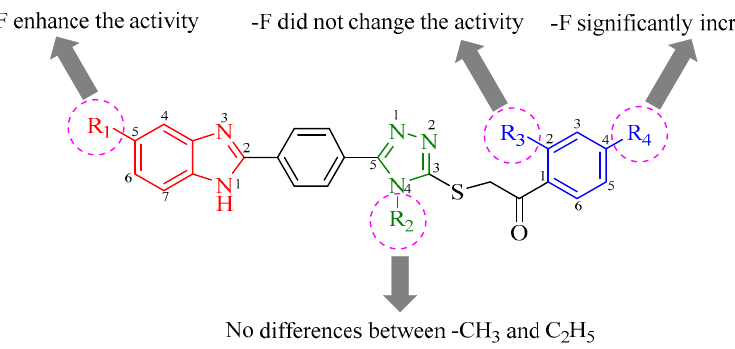
Figure 1. SARs outline of the compounds ( 5a – 5ad ). Table 2. MIC 50 (µg/mL) values of compounds ( 5a – 5ad ).